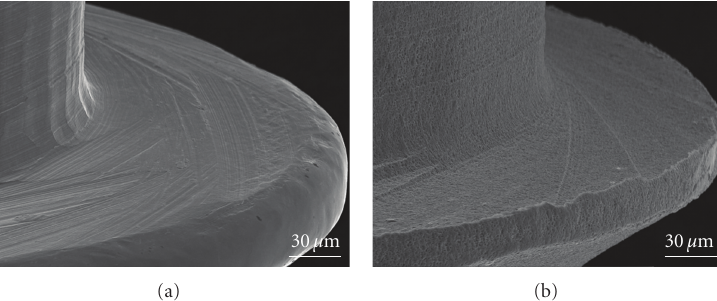
Figure 3: SEM images of OI surface morphology. (a) OI without surface treatment. (b) OI with acid surface treatment. Notice the grooves in the OI surface of the thread when compared with another which received acid surface treatment.